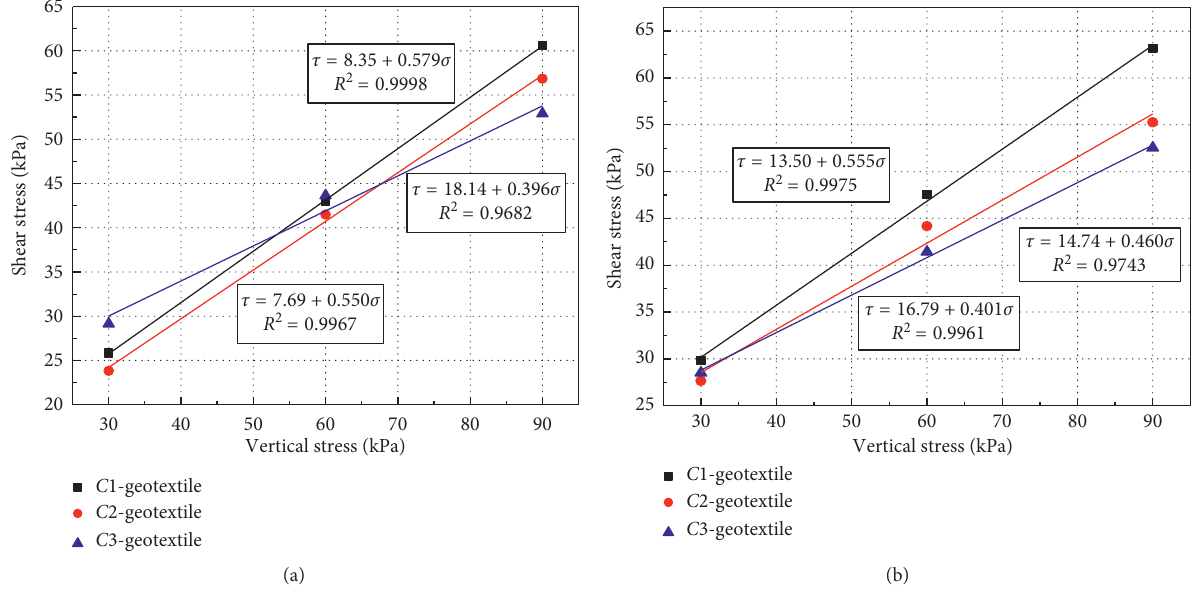
Figure 12: Shear strength envelopes for the (a) MDS and (b) PCDS